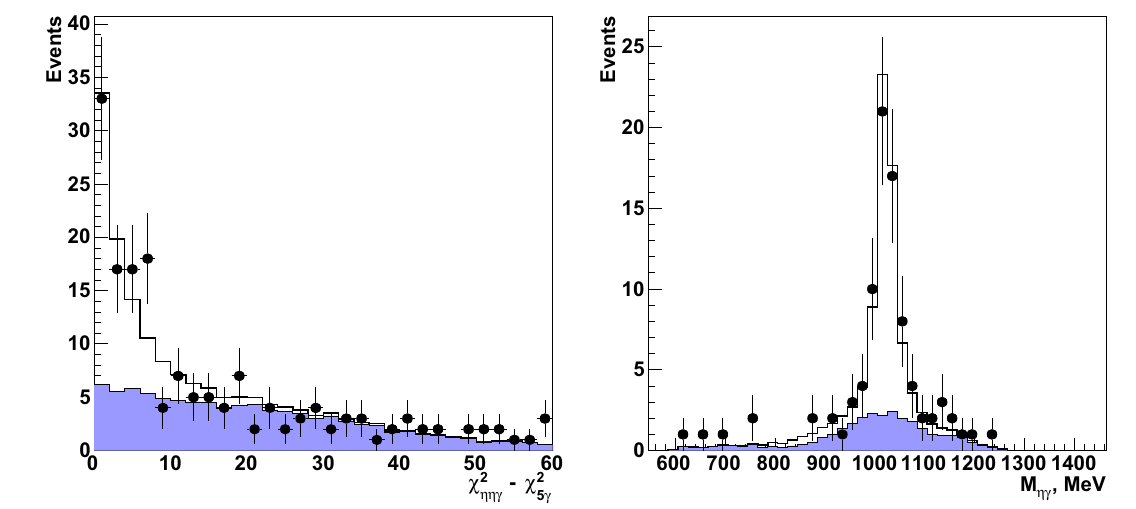
√ s = 1 . 57–2.00 GeV selected to the φ meson mass for data events with < 10 (points with error bars). with the tighter condition χ 2 ηηγ − χ 2 5 γ The solid histogram is the simulated signal plus background distribu- tion calculated with the fitted numbers of signal and background events. The shaded histogram is the simulated background distribution